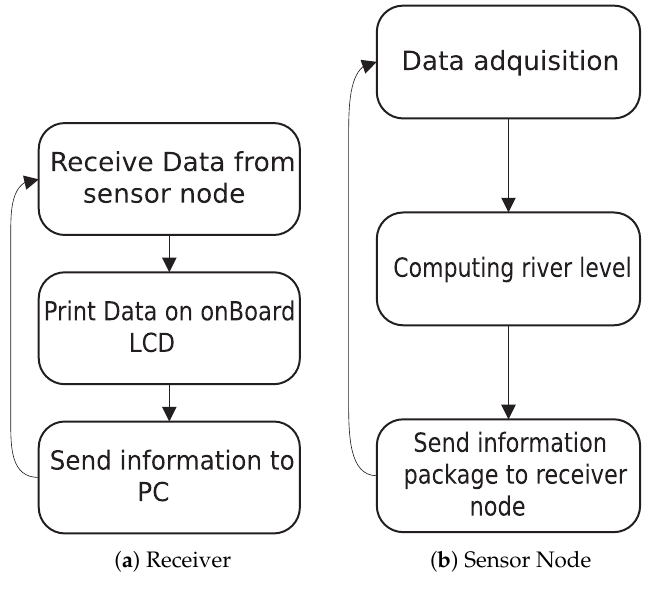
Figure 3. First prototype flux